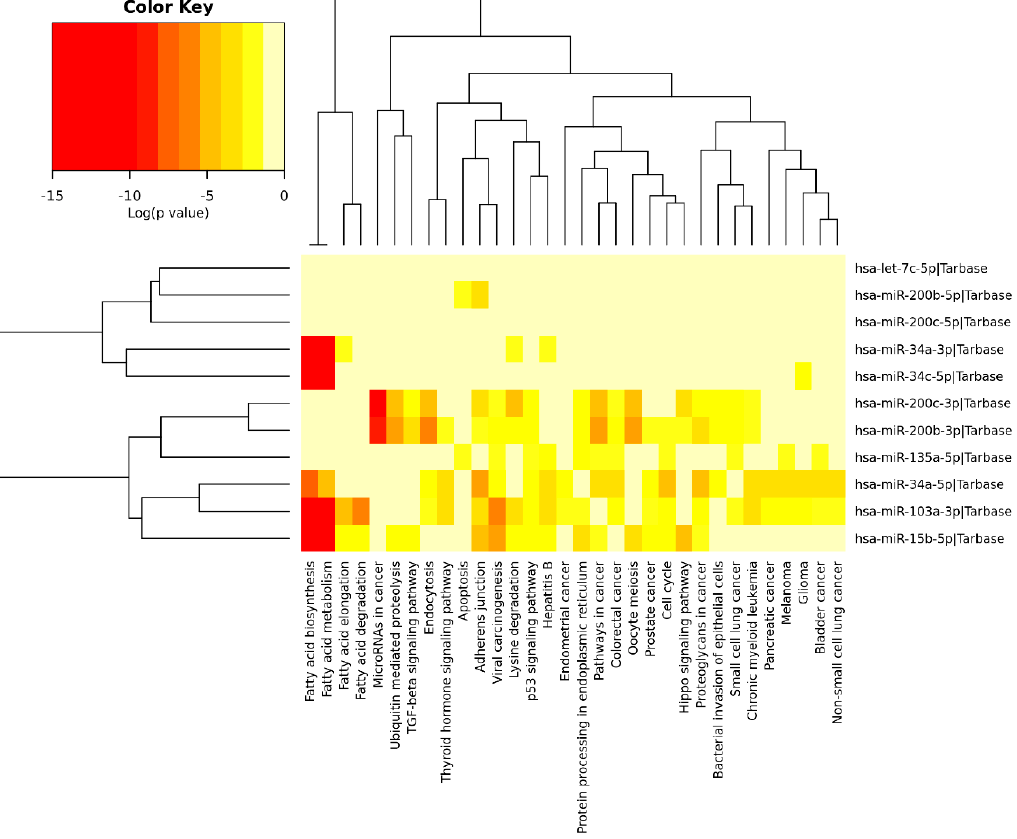
Figure 5. Heatmap clustering of miRNAs (brain samples) in Alzheimer’s disease vs. physical exercise and significant pathways’ interaction.